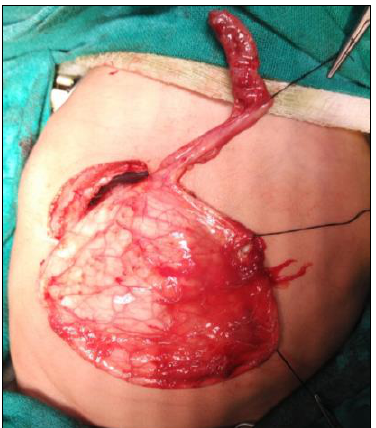
Figure 2: Peroperative view of hugely dilated